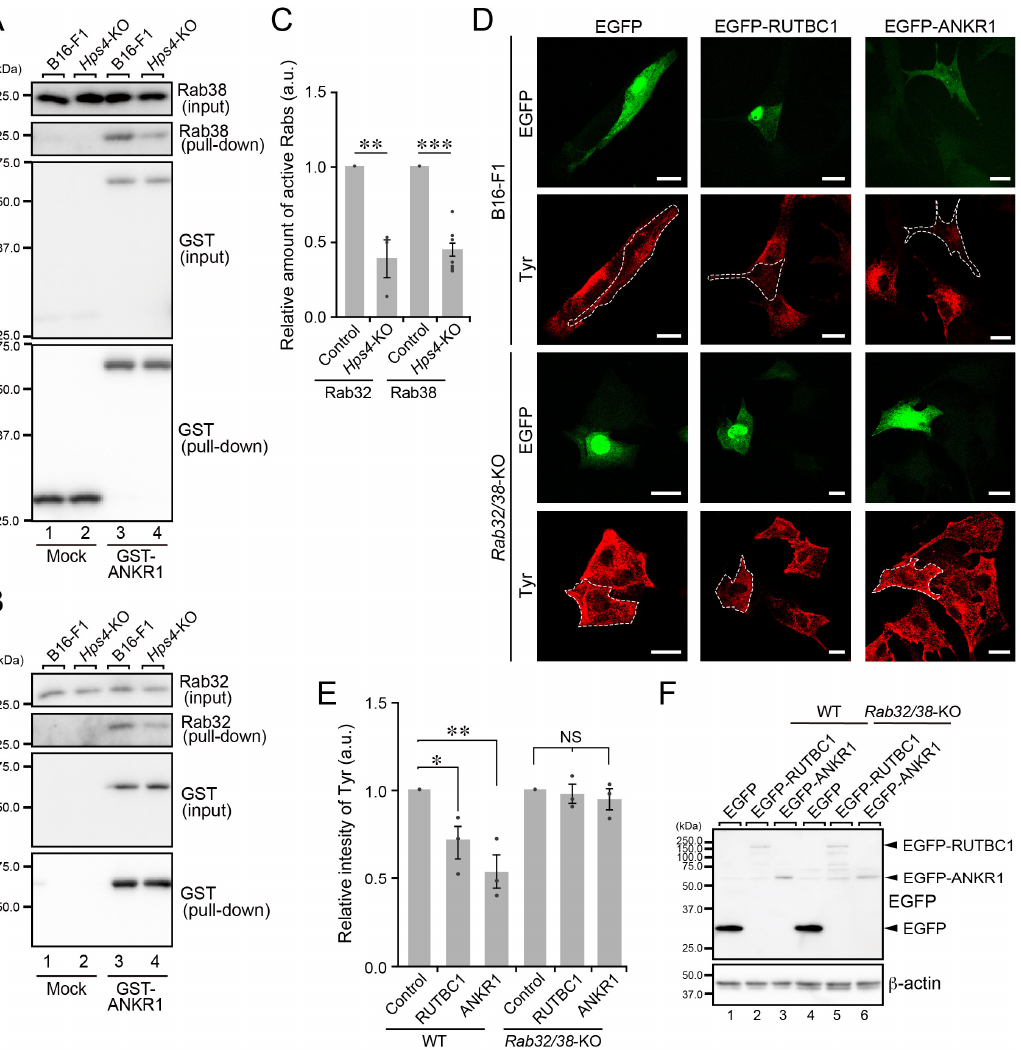
Figure 4. Decreased activation of Rab32/38 in Hps4 -KO B16-F1 cells and Rab32/38-independent Tyr transport in Rab32/38 -KO B16-F1 cells. ( A ) The amount of active Rab38 as determined by GTP-Rab38 pull-down assays, which were performed using the ANKR1 domain of Varp, i.e., Rab32/38 effector domain [22]. Beads coupled with GST alone (control) or GST-Varp-ANKR1 were incubated with lysates of WT cells or Hps4 -KO B16-F1 cells, and the proteins bound to the beads were analyzed by immunoblotting with the antibodies indicated. ( B ) The amount of active Rab32 as determined by the GTP-Rab32 pull-down assays, which were performed using GST-Varp-ANKR1 essentially as described in ( A ). ( C ) The intensity of the active GTP-Rab32 bands (second panel in ( B ); n = 3) and GST-Rab38 bands (second panel in ( A ); n = 5) normalized by the total number of Rab32 and Rab38 bands (top panel in ( A , B )), respectively, were quantified and analyzed statistically (**, p < 0.01; ***, p < 0.001; Student’s unpaired t -test). ( D ) Representative Tyr images (red) of WT cells and Rab32/38 -KO B16-F1 cells expressing either EGFP alone, EGFP-RUTBC1 [29], or EGFP-ANKR1 [31]. The EGFP-expressing cells (green) are outlined with broken white lines. Scale bars, 20 µ m. ( E ) Relative intensity of Tyr in the WT cells and Rab32/38 -KO B16-F1 cells shown in ( D ). The graph shows the means and SEM of the data obtained in three independent experiments ( n > 10 cells in each experiment). *, p < 0.05; **, p < 0.01; NS, not significant (Dunnett’s test). ( F ) Expression of EGFP-tagged proteins in WT cells and Rab32/38 -KO B16-F1 cells. Lysates of the cells indicated were analyzed by immunoblotting with antibodies against GFP (top) and β -actin (bottom).